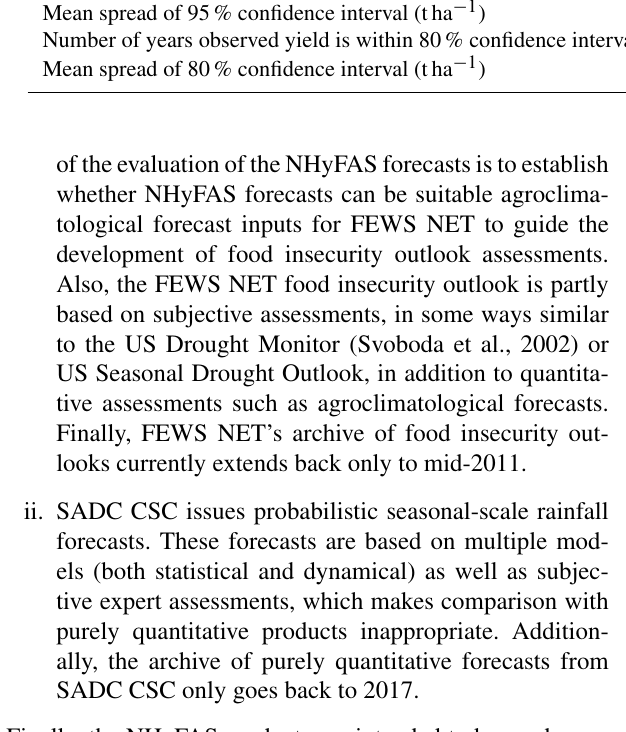
Univariate Univariate